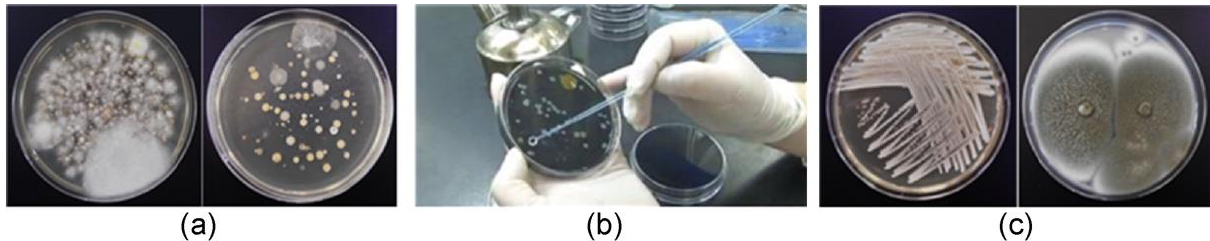
Figure 1. Procedure for pure culture isolation: ( a ) culturing of bacterial and fungal spores; ( b ) subculturing; ( c ) confirmation of pure culture isolation status.